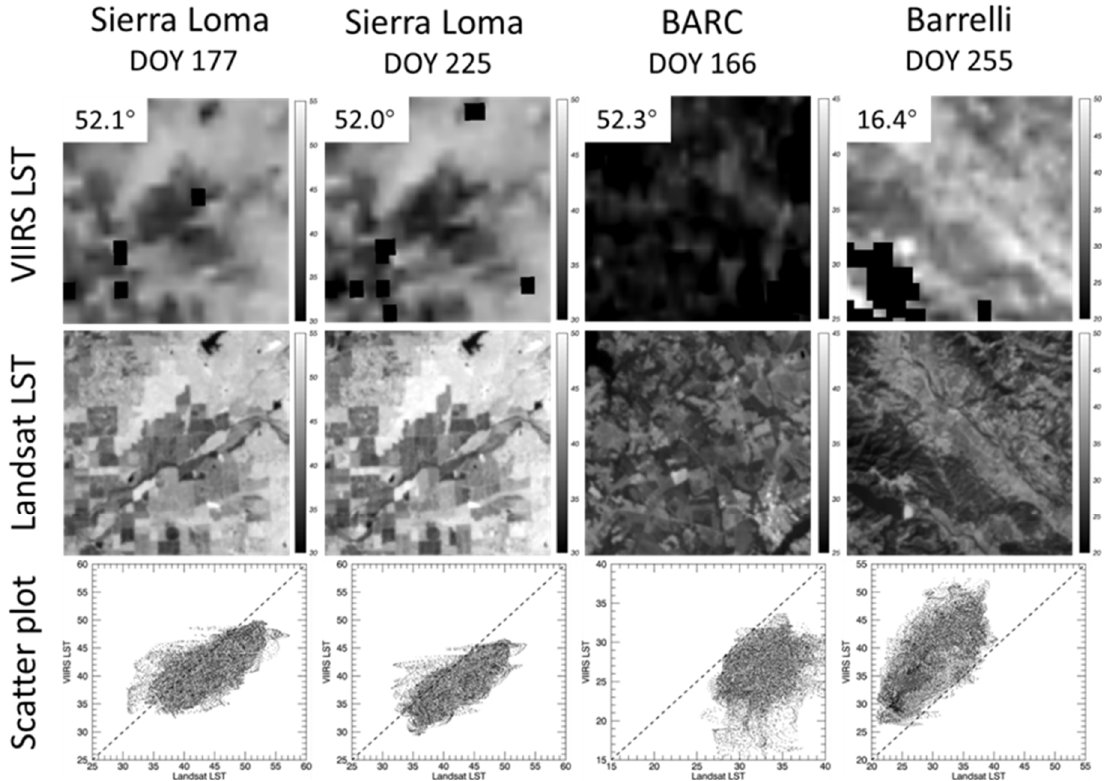
Figure 13. Comparison of VIIRS ( up row ) and Landsat LST ( middle row ) at native resolution on days with different view angles over Sierra Loma, BARC and Barrelli domain (400 × 400 pixels), with corresponding scatter plots of VIIRS and Landsat LST shown in the ( bottom row ).